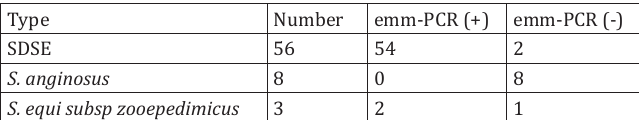
Detection of the emm gene in SDSE and S. anginosus isolates.